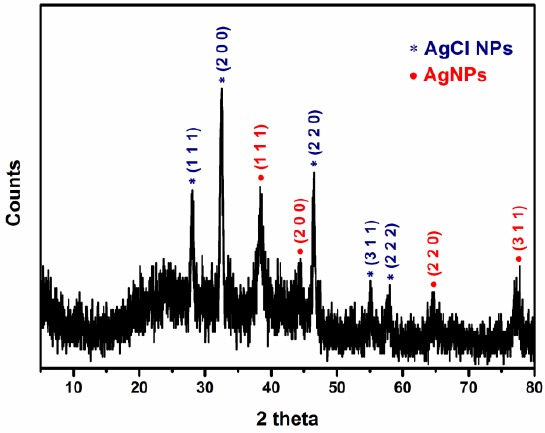
Figure 6. X-ray diffraction patterns of biosynthesized AgNPs (dot circle) and AgCl NPs (asterisk).